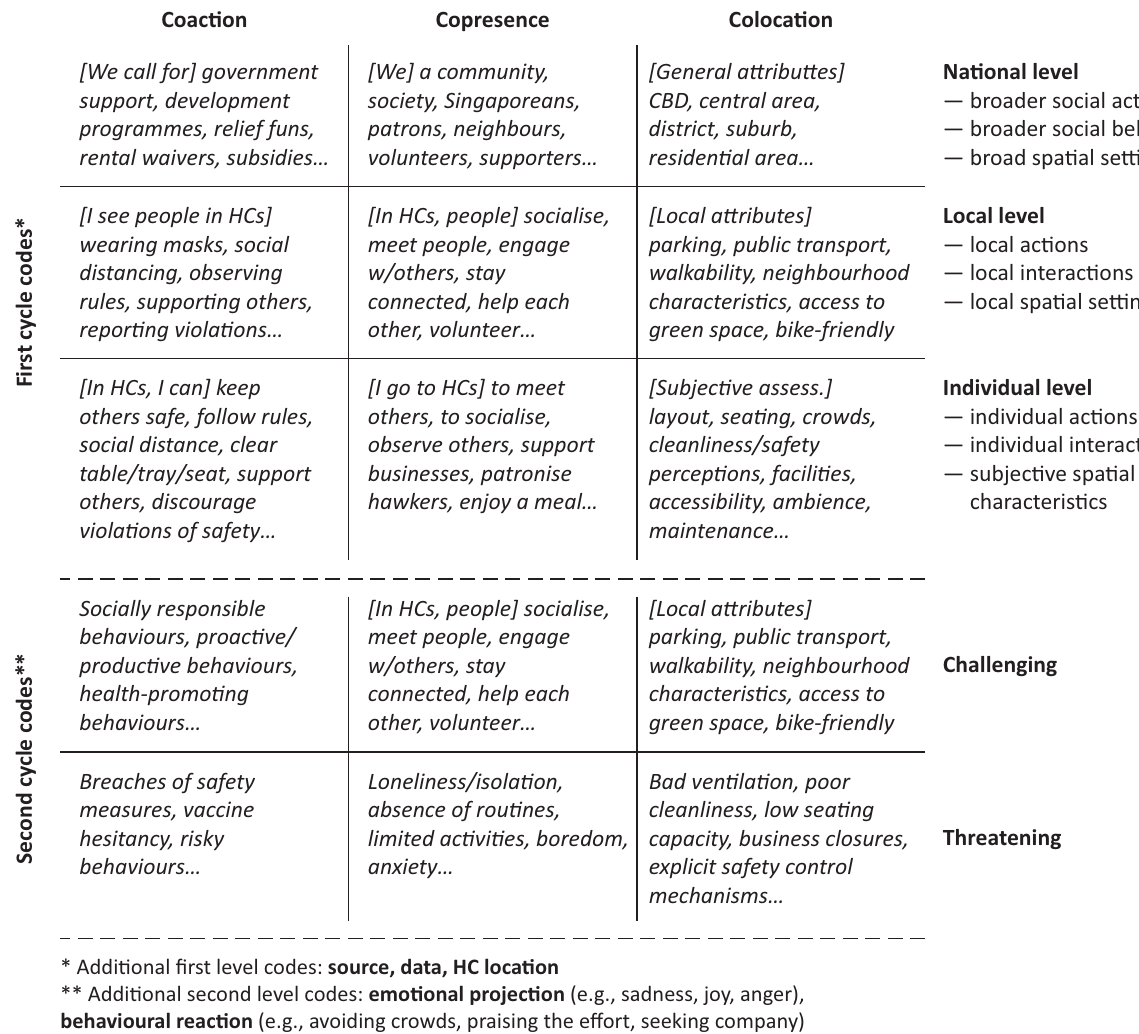
table/tray/seat, support others, discourage